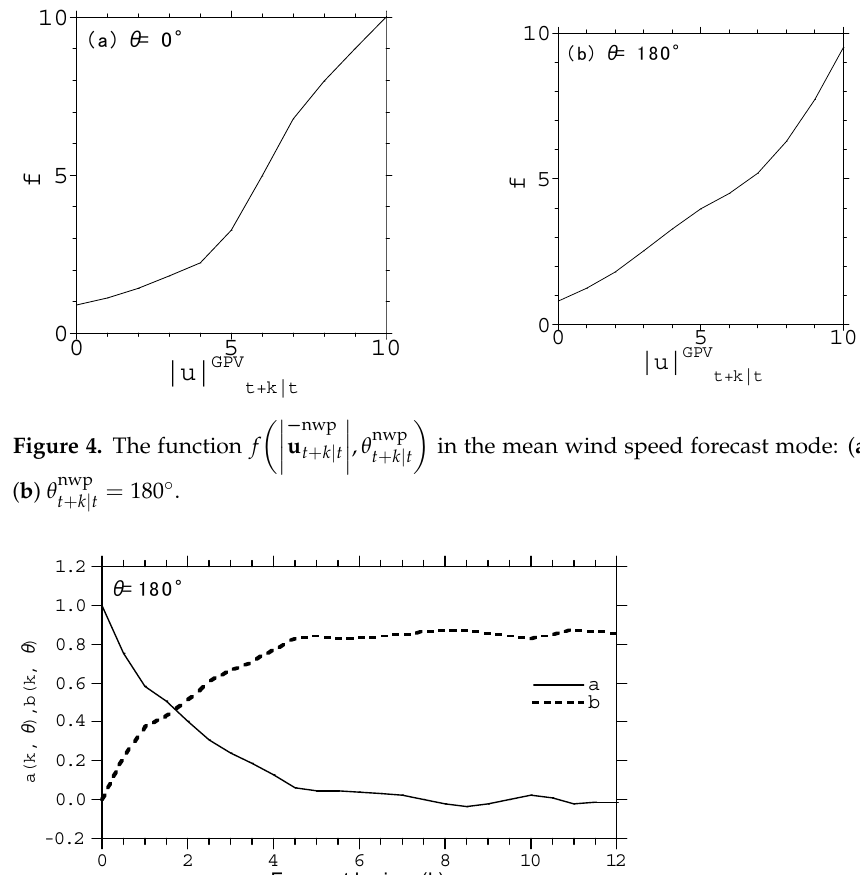
Figure 5. The training result of a ( k , θ ) and b ( k , θ ) in the mean wind speed forecast model for southerly wind ( 𝜃 (cid:3047)(cid:2878)(cid:3038)|(cid:3047)(cid:2924)(cid:2933)(cid:2926) = 180° ).